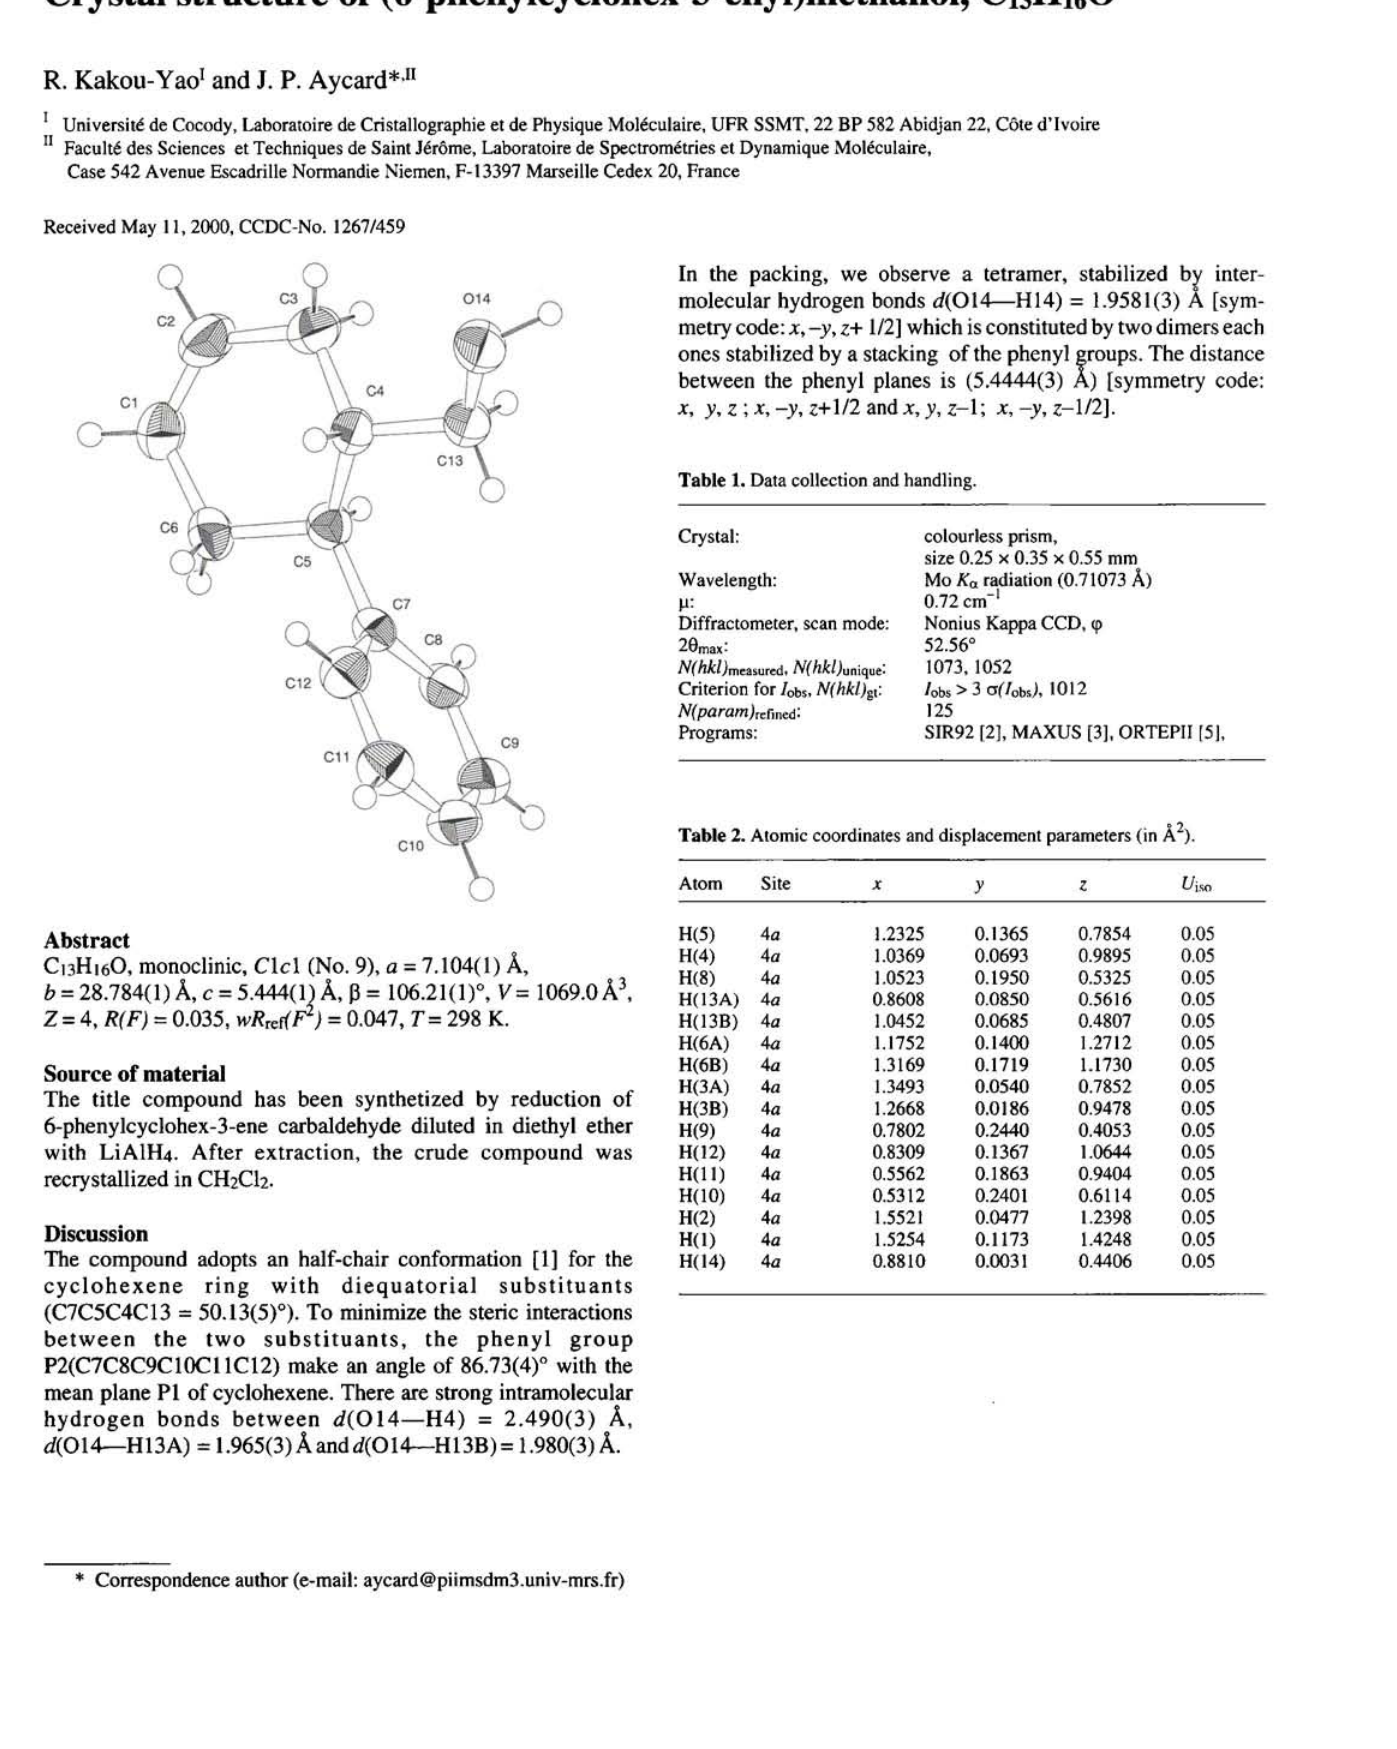
Table 1. Data collection and handling.